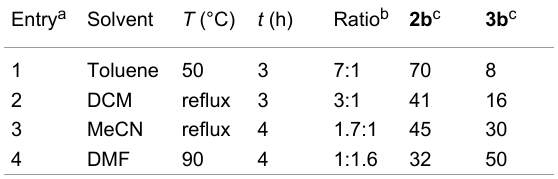
Table 2: Effect of the solvent on the ratio of the isomeric products. Entry a